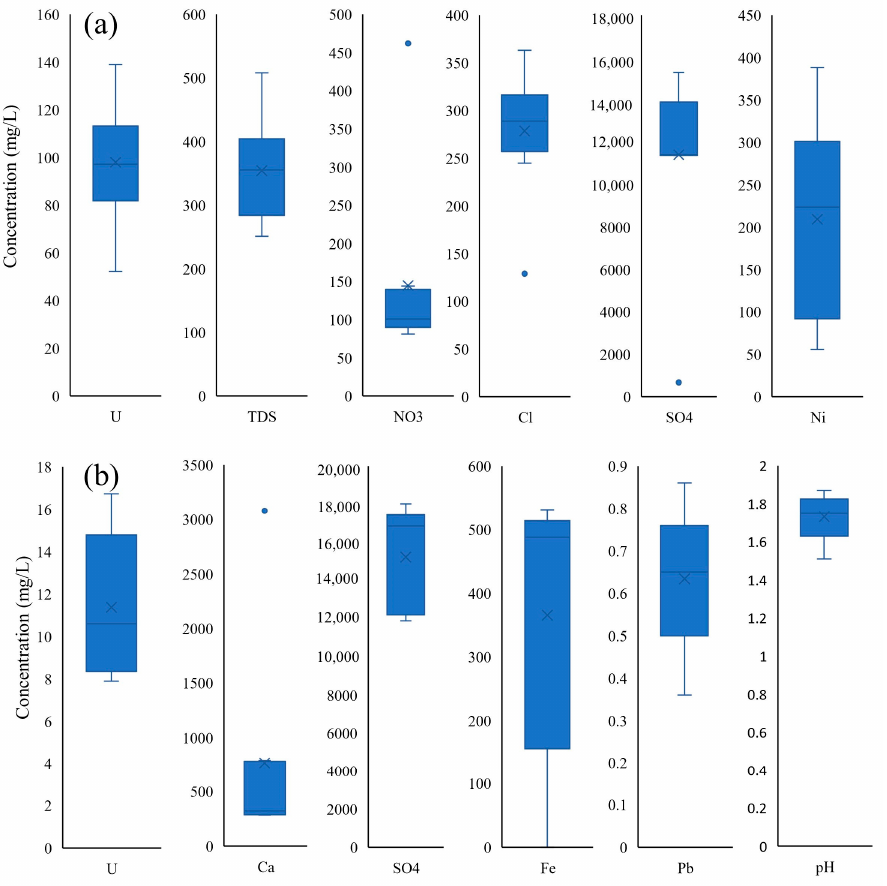
Figure 7. The statistical data of the main pollution ions in the acid-leaching ( a ) and CO 2 -leaching ( b ) mining areas [89–91,100].